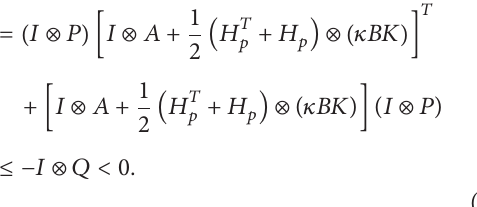
Figure 4: Three interconnection topology